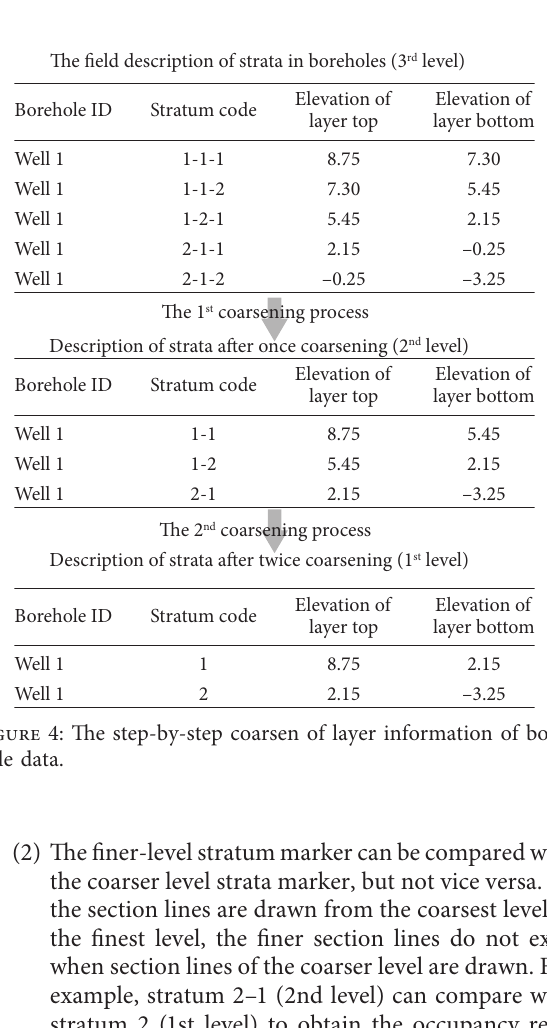
Figure 3: The organization form of borehole data.